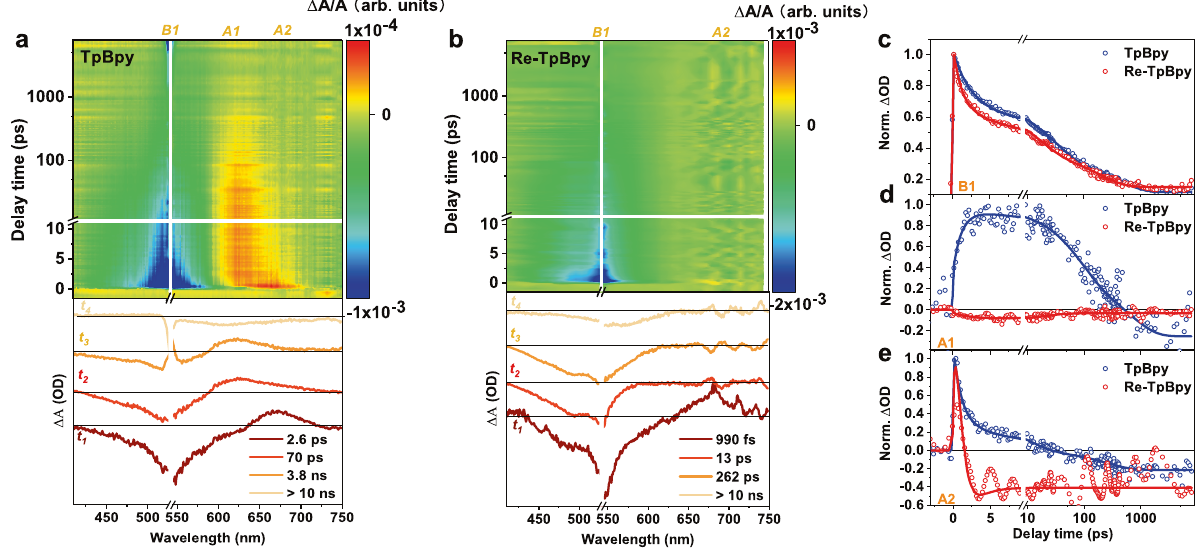
Fig. 5 Transient absorption (TA) study at band-edge excitation. TA spectra under 530 nm excitation at the fl uence of 2 × 10 13 ph/cm 2 and the respective SVD fi tting results of TpBpy ( a ), and Re-TpBpy ( b ). TA kinetics at some characteristic wavelength of B1 at 535 nm ( c ), A1 at 625 nm ( d ), and A2 at 675 nm ( e ). All the samples were measured in Na fi on (5% w/w in water and 1-propanol) solution. Source data are provided as a Source data fi